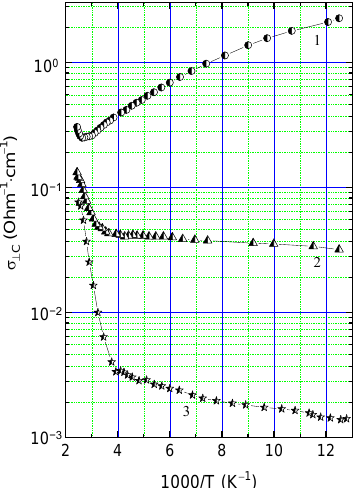
Figure 3. Scanning electron microscope micrographs showing cleaved surfaces of ( a ) as-grown pristine, ( b ) Co-intercalated and ( c ) Co-doped InSe crystals.